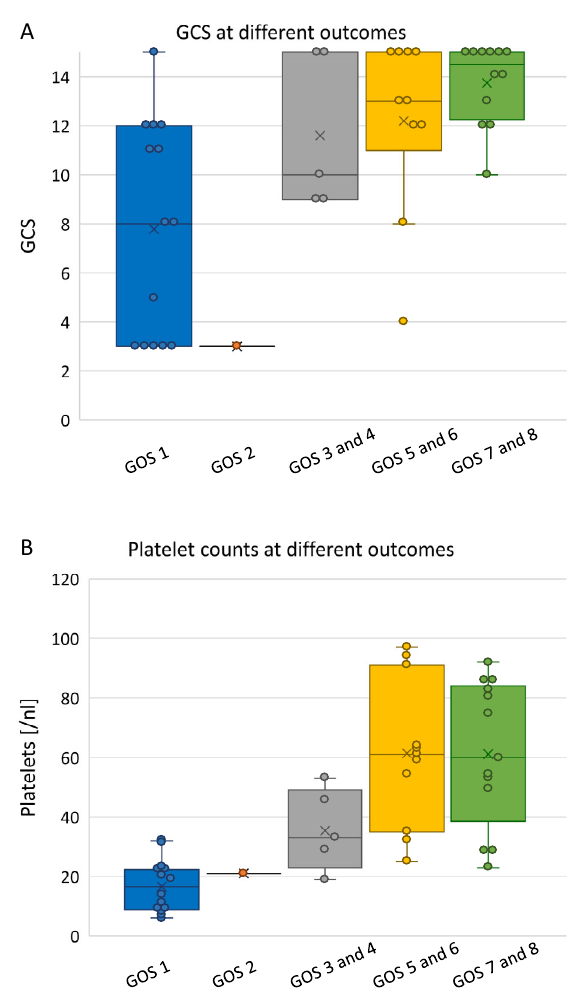
Fig. 1 GCS and platelet counts at different outcomes. A GCS versus GOS of 42 patients with CVST. Patients with no information on GCS available are excluded ( n = 42). Box plots show median (center line), mean (cross), 25% (Q1), and 75% (Q3) percentiles (interquartile range (IQR)), outliers, lower whisker as Q1 – 1.5 × IQR and upper whisker as Q3 + 1.5 × IQR. Each dot represents a single patient. Spearman Correlation Coef fi cient was calculated with α = 0.05 ( r = 0.60, P < 0.001). B Outcome of 44 patients with CVST in relation to platelet count nadirs. Box plots show median (center line), mean (cross), 25% (Q1), and 75% (Q3) percentiles (interquartile range (IQR)), lower whisker as Q1 – 1.5 × IQR, and upper whisker as Q3 + 1.5 × IQR. Each dot represents a single patient. Spearman Correlation Coef fi cient was calculated with α = 0.05 ( r = 0.73, P <